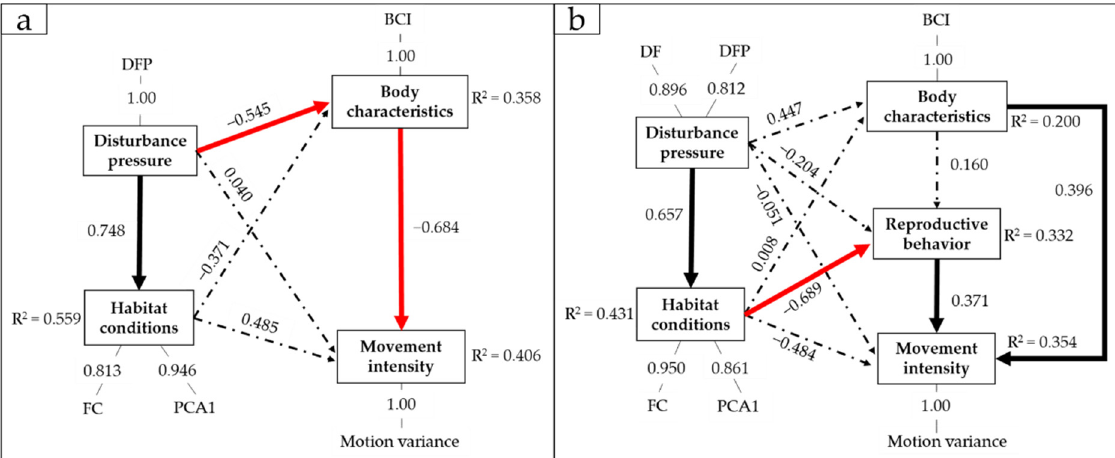
Figure 3. The path coefficients of PLS-PM prediction in ( a ) males and ( b ) females. DFP: distance to forest path; DF: distance to farmland; FC: forest coverage. The black solid lines indicate a significant positive correlation between variables. Red solid lines indicate a negative correlation. The dotted lines indicate that there is no significant correlation between variables.